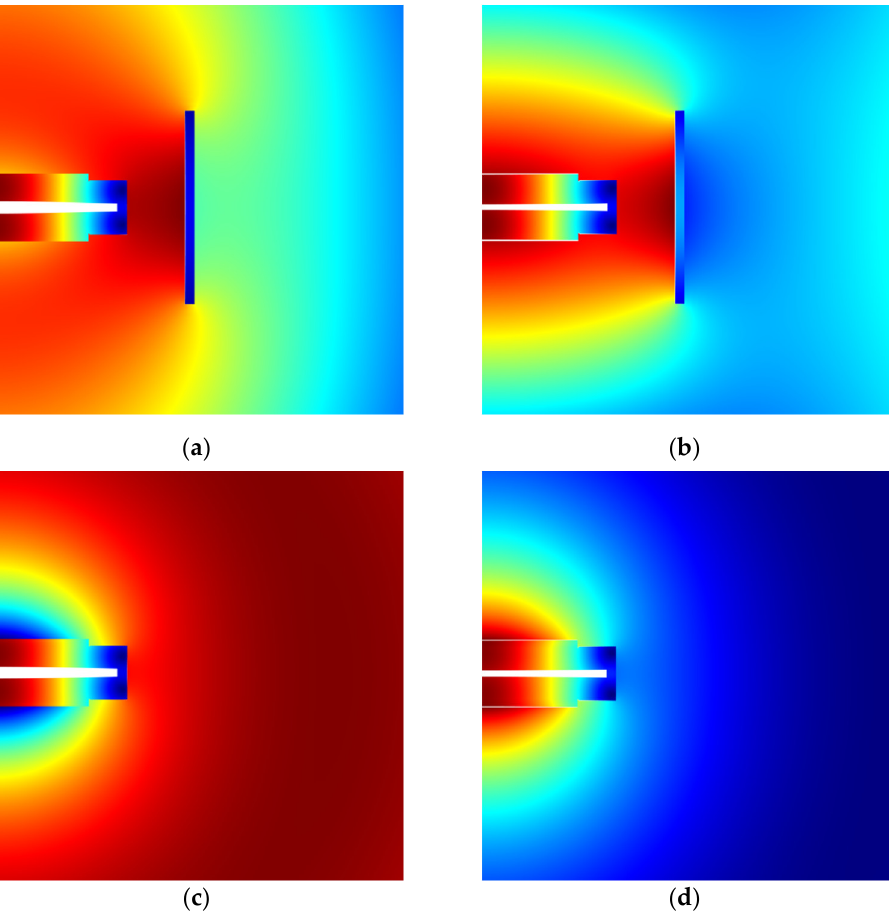
Figure 5. Impedance difference with and without baffle. The resonant frequency of the free-flood breathing mode of a ring is given by [30]: 1/2 0 (4) where b r is radius, L is length, t is thickness,  is density, c is ring longitudinal wave velocity of the ring, and  0 is fluid density. The resonance frequency of the baffle is far away from the bending vibration resonance frequency of the bender, and the effect of the vibration in the research calculation range can be ignored.